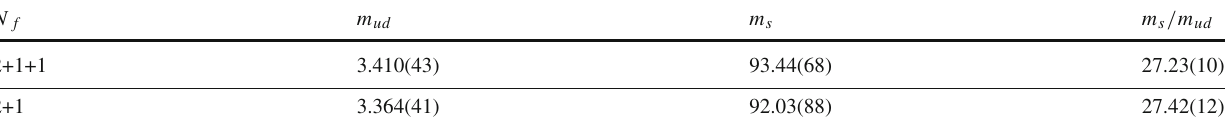
Table 10 Our estimates for the strange-quark and the average up-down-quark masses in the MS scheme at running scale μ = 2GeV. Mass values are given in MeV. In the results presented here, the error is the one which we obtain by applying the averaging procedure of Sect. 2.3 to the relevant lattice results.